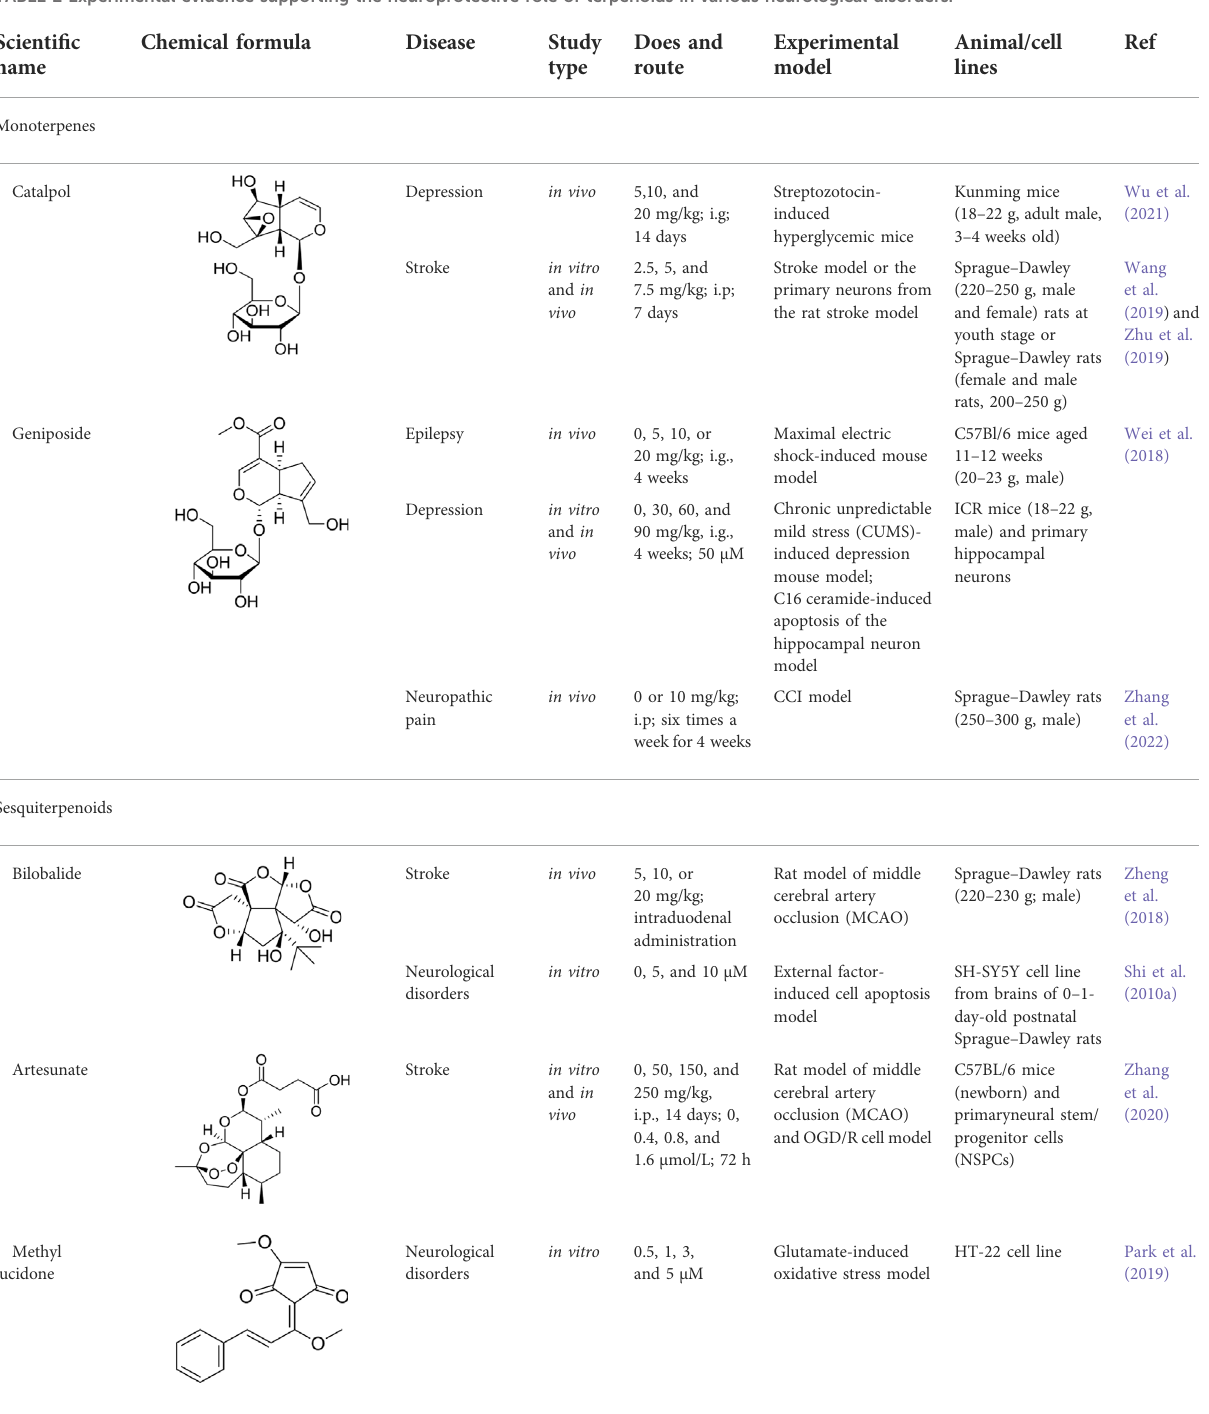
TABLE 2 Experimental evidence supporting the neuroprotective role of terpenoids in various neurological